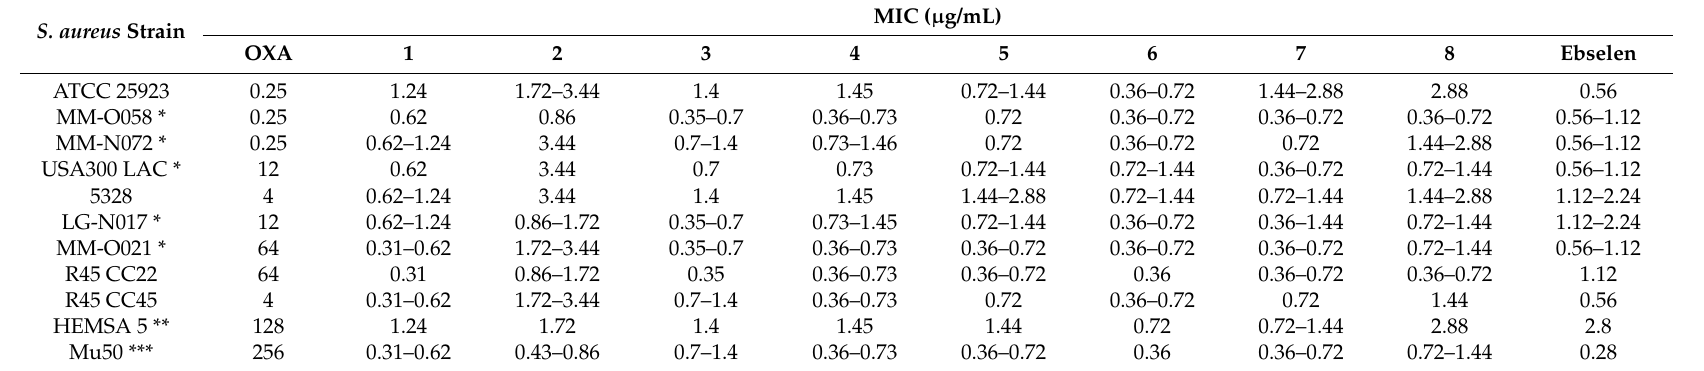
Table 3. Antibacterial activities (MICs) of compounds 1 – 8 against different strains of S. aureus